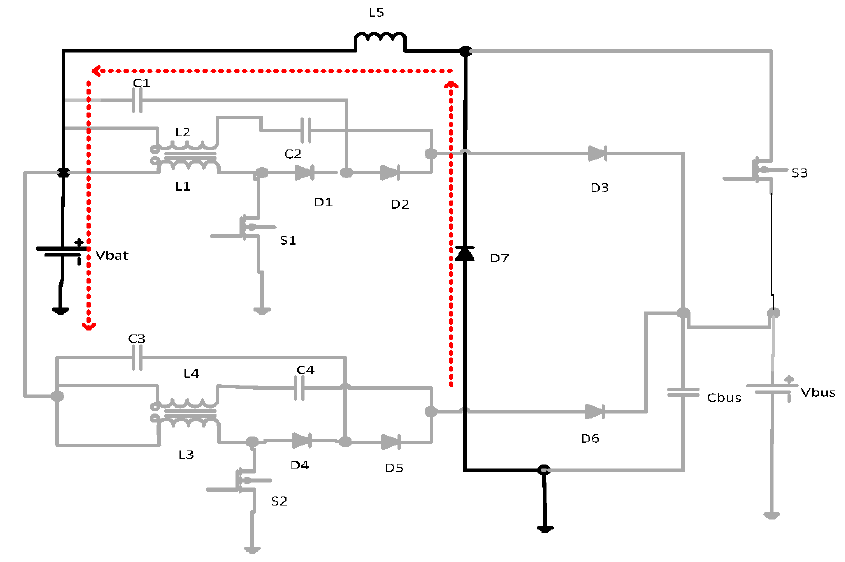
Figure 5. Mode 2 (switch opened).